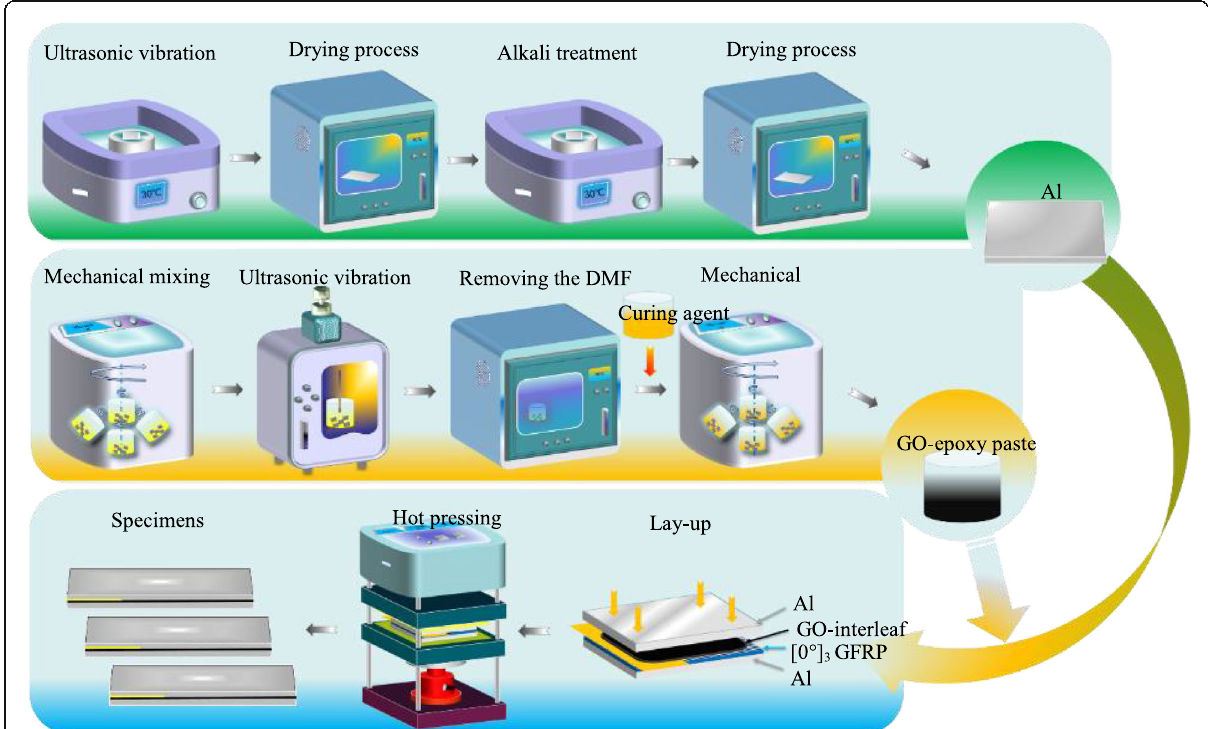
Fig. 1 Schematic illustration of specimen fabrication and hot pressing